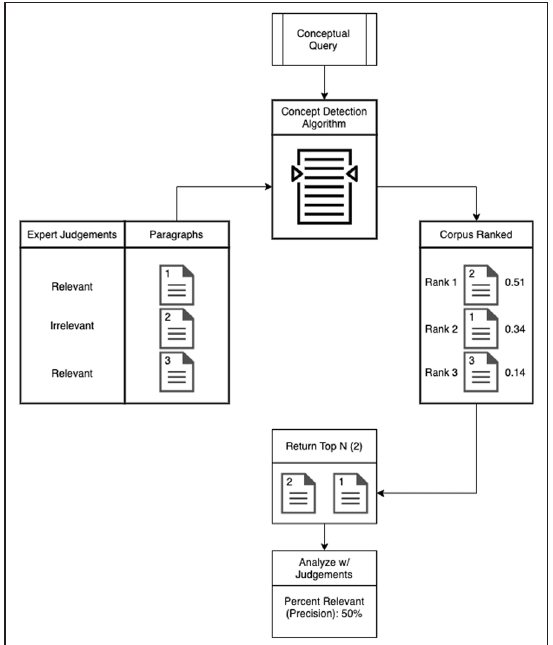
Figure 5: Experiment